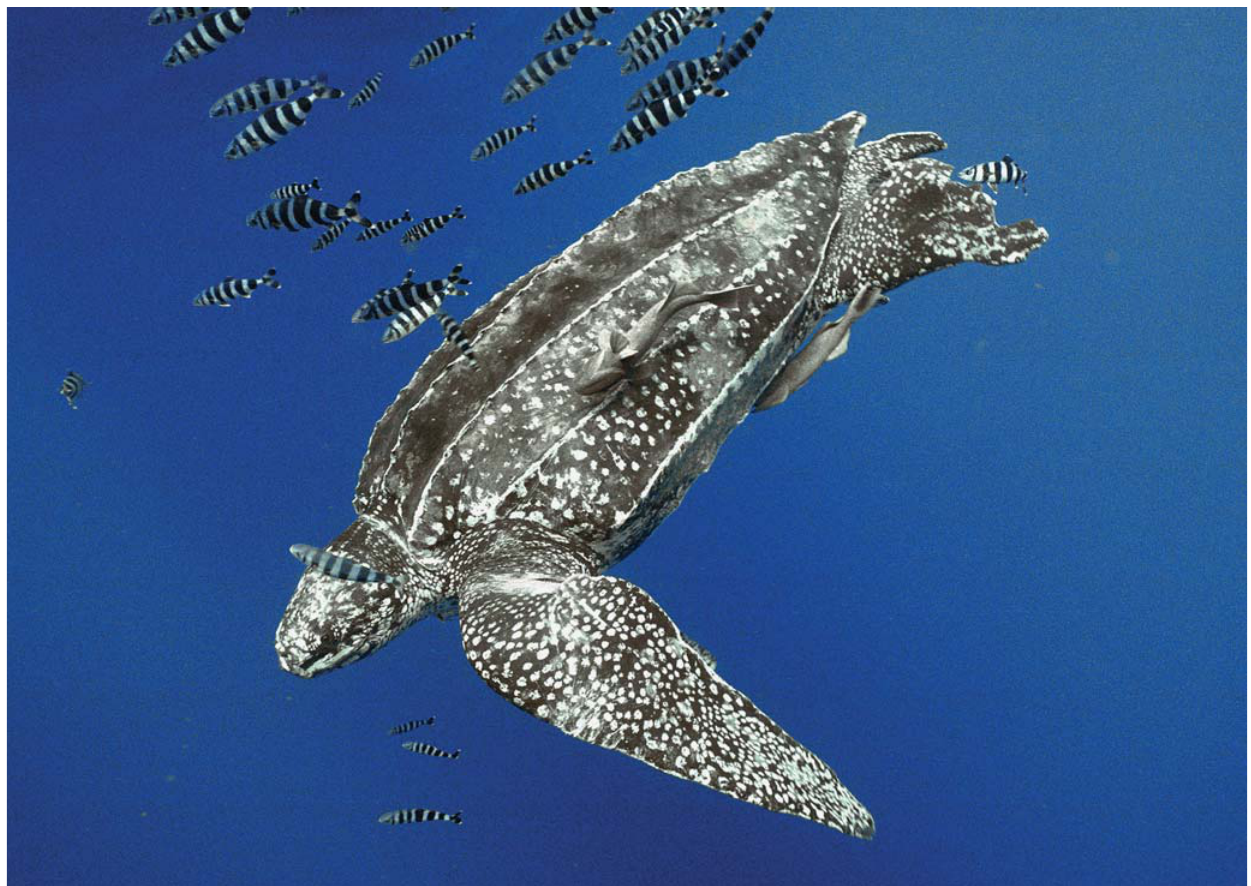
Fig. 1. A leatherback turtle ( Dermochelys coriacea ) with an adult couple of the common remora ( Remora remora ), one of the fish moving over the carapace (left side) and the other attached to the plastron. A group of pilotfish ( Naucrates ductor ) travels with the turtle. Photo by G.